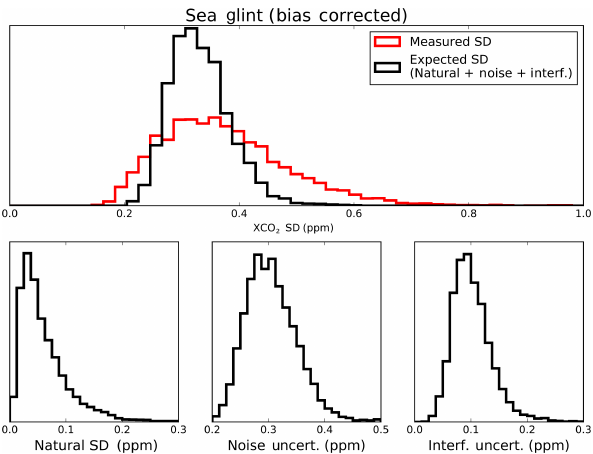
Figure A2. Same as Fig. A1 but using only data with “warn lev- els”<10.